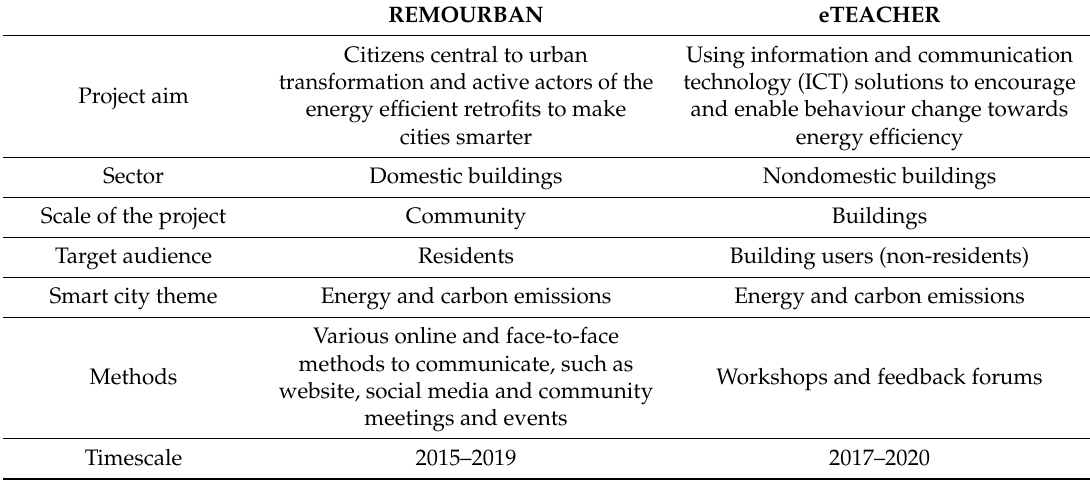
Table 2. Overview of REMOURBAN and